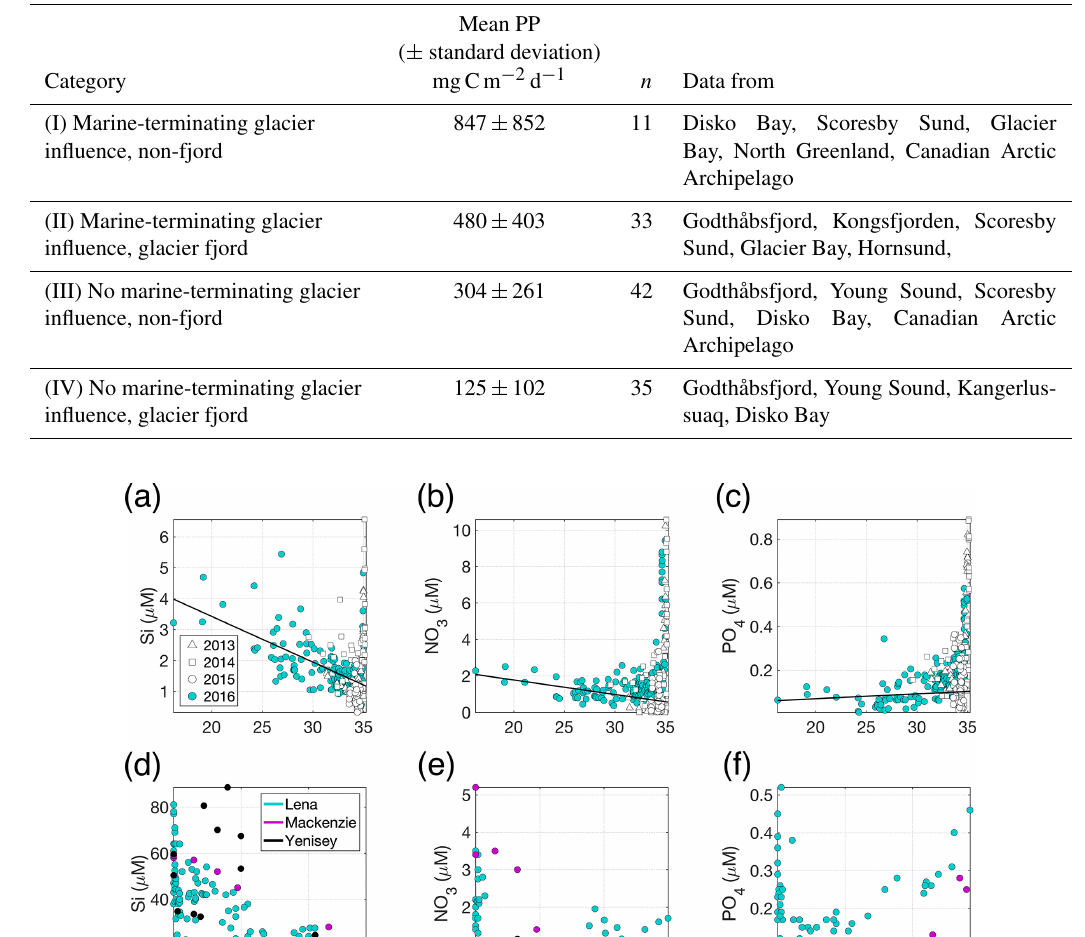
Table 1. July–September marine primary production (PP) data from studies conducted in glaciated Arctic regions. PP data points are cate- gorised into four groups according to whether or not they are within 80km of a marine-terminating glacier and whether or not they are within a glacier fjord. Data sources as per Fig. 2. n is the number of data points; where studies report primary production measurements at the same station for the same month at multiple time points (e.g. Juul-Pedersen et al., 2015) a single mean is used in the data compilation (i.e. n = 1 irrespective of the historical extent of the time series).